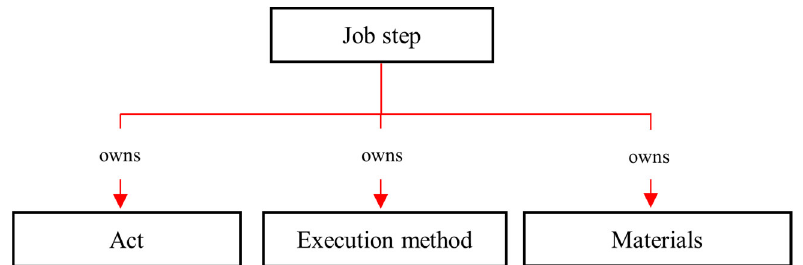
Figure 4. The sub-concepts of job step.